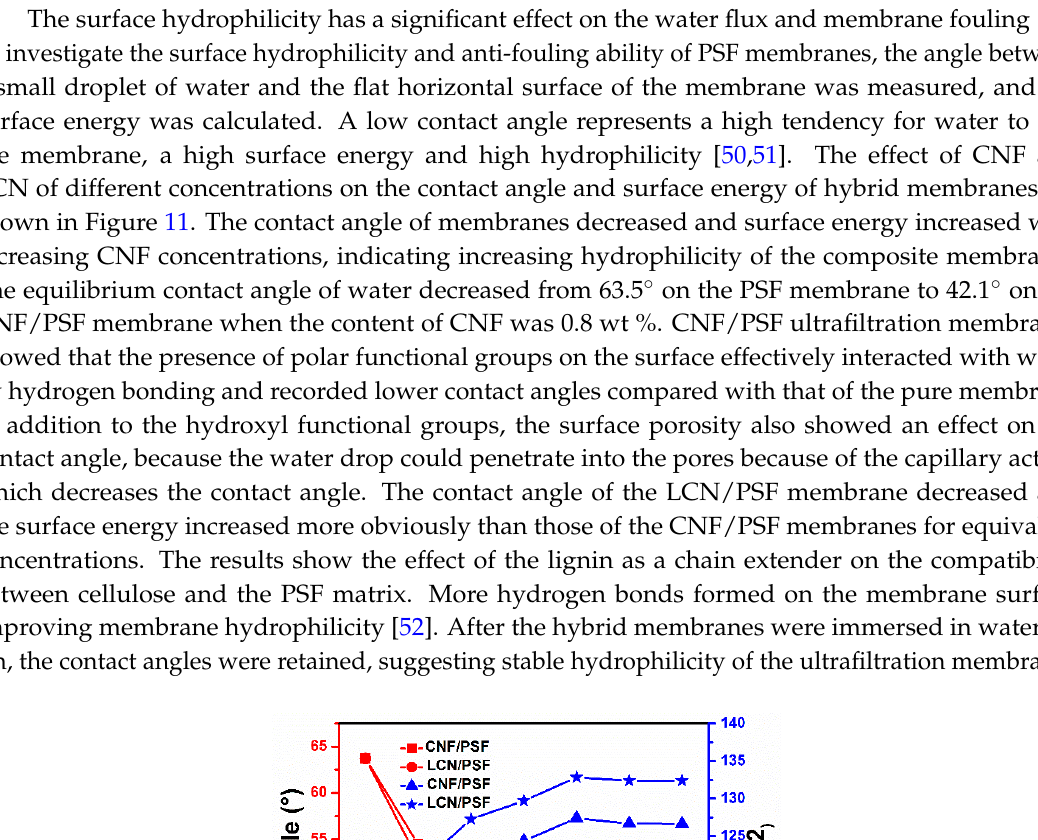
Figure 12. Effects of the CNF and LCN content on the tensile strength and breaking elongation of the membranes. Table 4. Young’s modulus of membranes (MPa). Sample